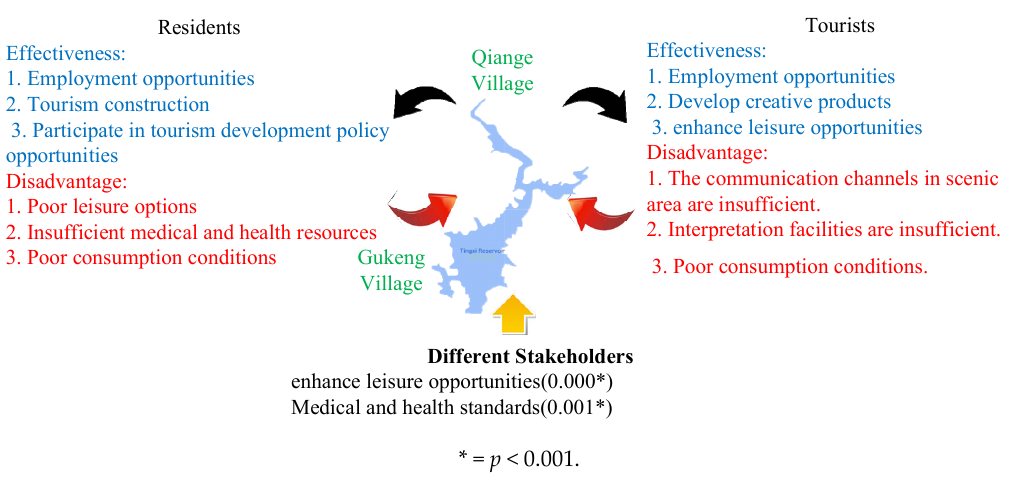
Figure 3. Perception analysis of the current economic development.